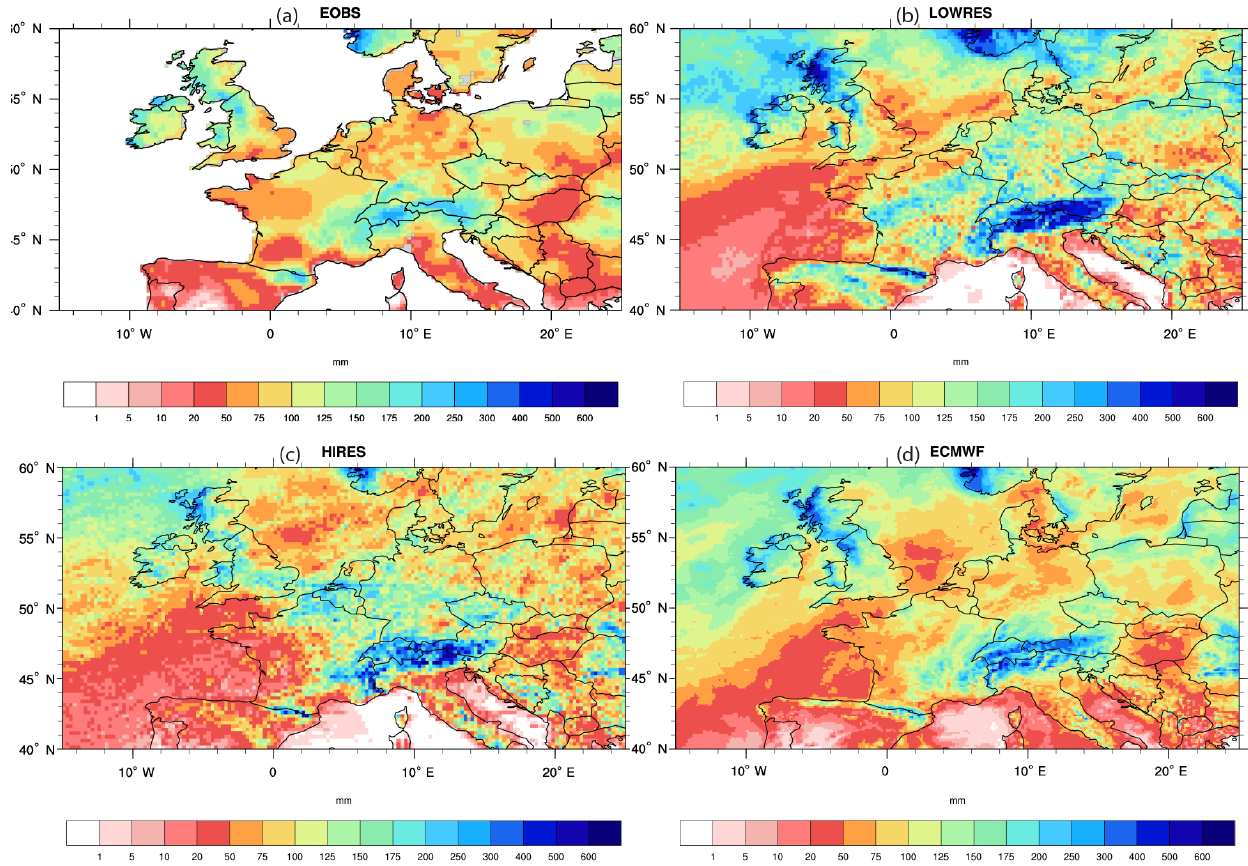
Figure 18. The 2-month accumulated precipitation over Europe. Panel (a) shows the E-OBS data set, (b) shows the LOWRES simulation, (c) displays the HIRES simulation, and (d) shows the ECMWF forecast.